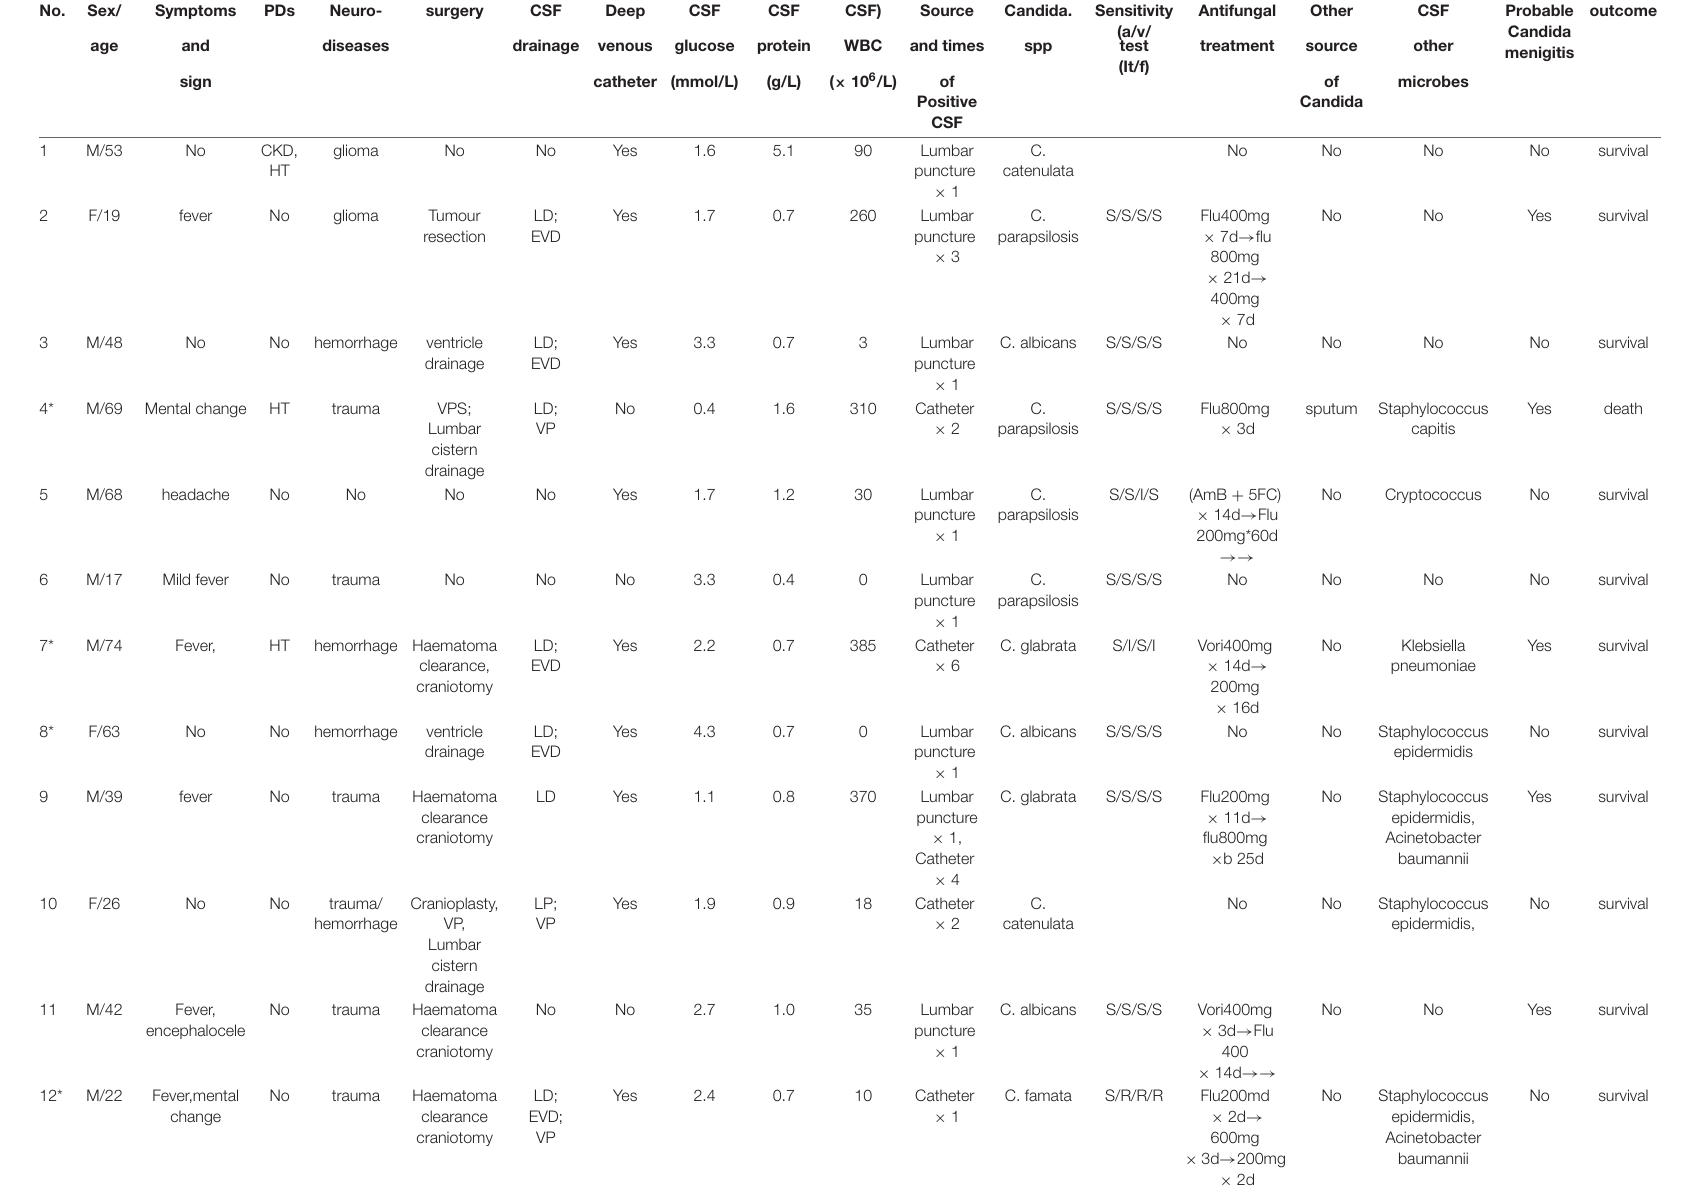
TABLE 1 | The Clinical features of patients with Candida spp. in CSF. No.